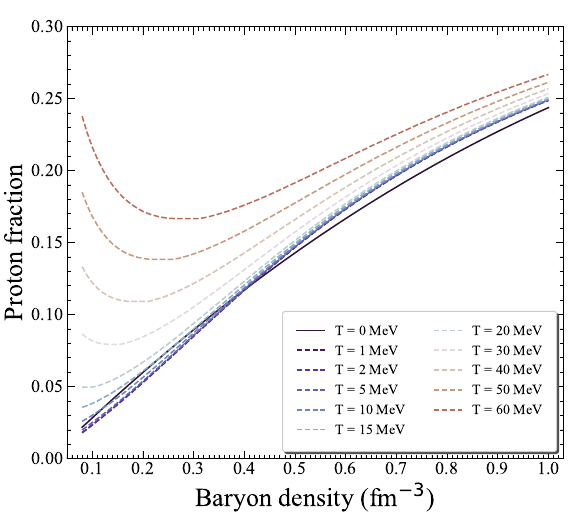
Figure 3. The proton fraction as a function of the baryon density for temperatures in the range [0 , 60] MeV. The cold configuration is presented with the solid line and the hot ones with the dashed lines.